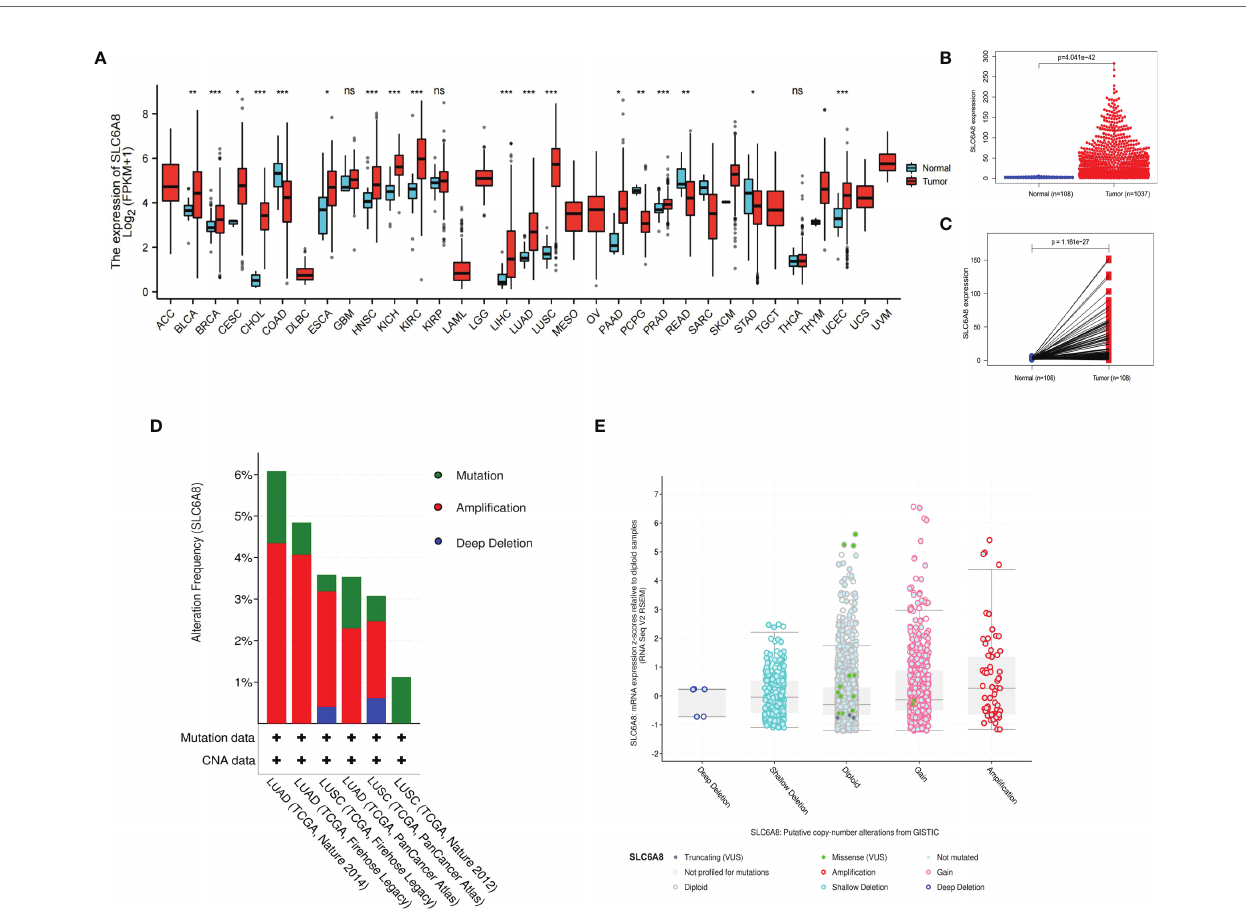
FIGURE 1 | Expression of SLC6A8 in lung cancer (A) Expression of SLCA8 in pan-cancer *P-value < 0.05; **P-value < 0.01; ***P-value < 0.001. (B) Unpaired differential expression and (C) paired differential expression of SLC6A8 in NSCLC in TCGA database. (D) Gene alteration and copy number (E) analysis of SLCA8 in NSCLC in the eBioPortal online database. ns, no signi fi